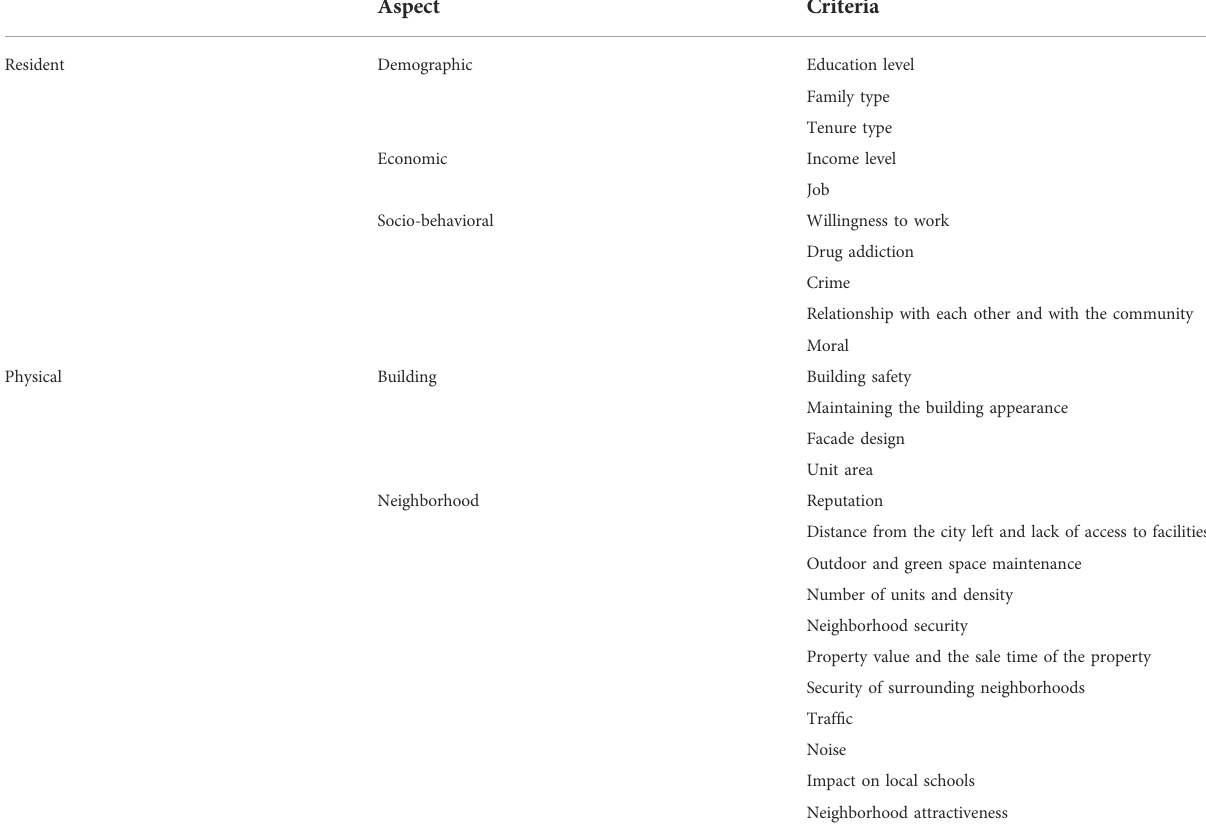
TABLE 1 Aspects and criteria of attitudes toward